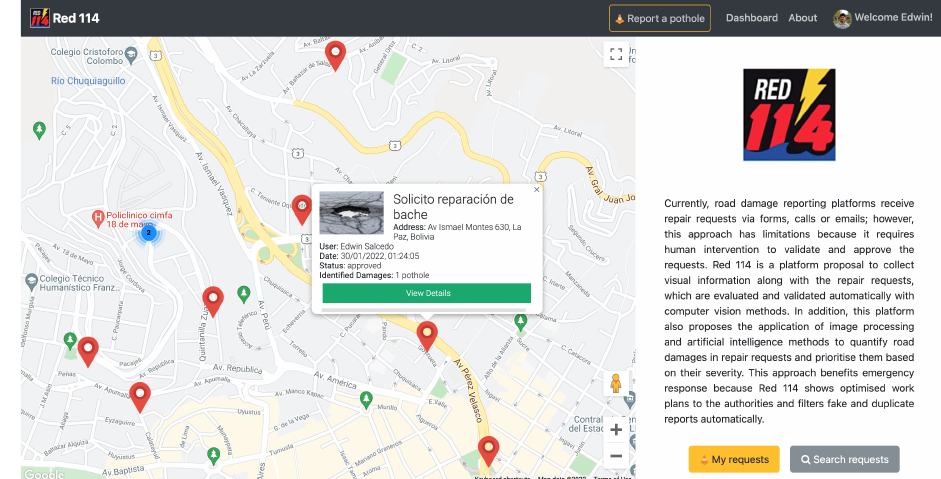
Figure A1. Main interface of the web